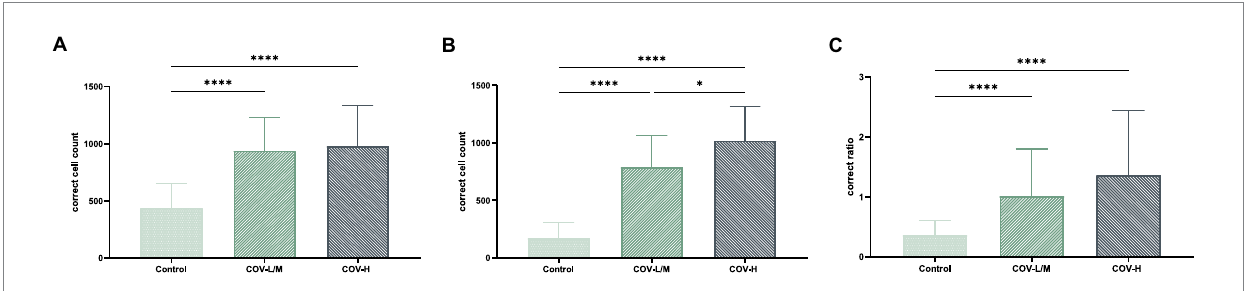
FIGURE 13 Comparative histogram of each macrophage count in each COVID-19 group and Control group (A) total macrophages, (B) M2-type macrophages, [ (C) M2/total macrophage ratio; * p < 0.05, **** p <